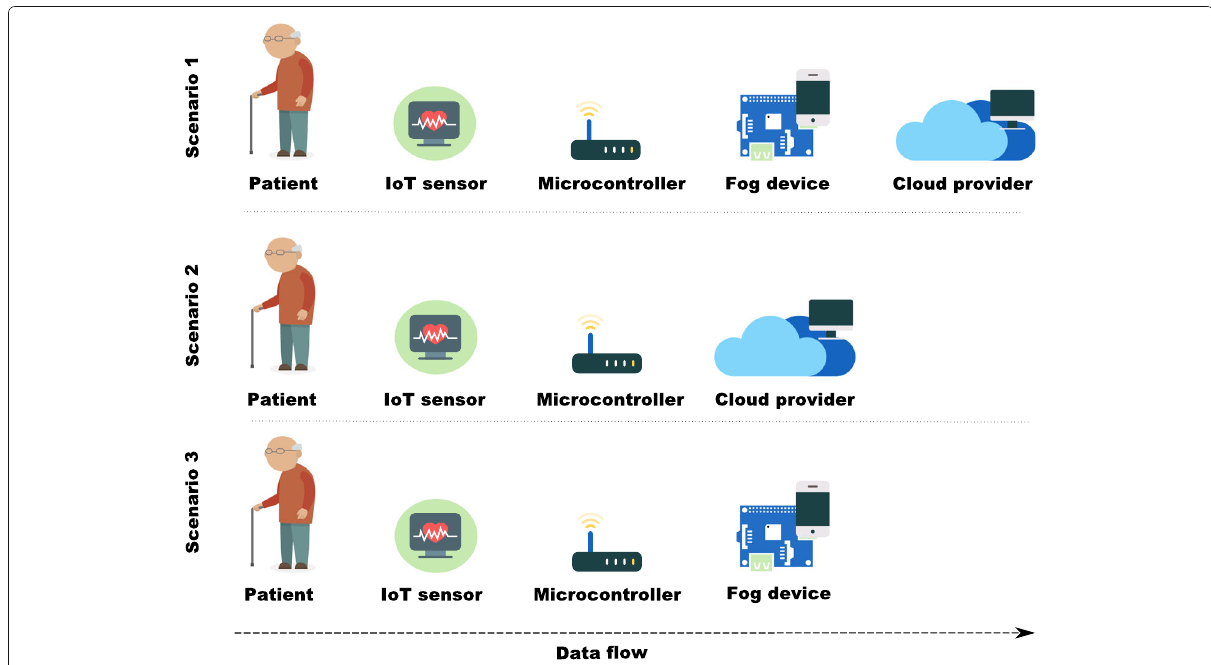
Fig. 4 E-health monitoring system scenarios